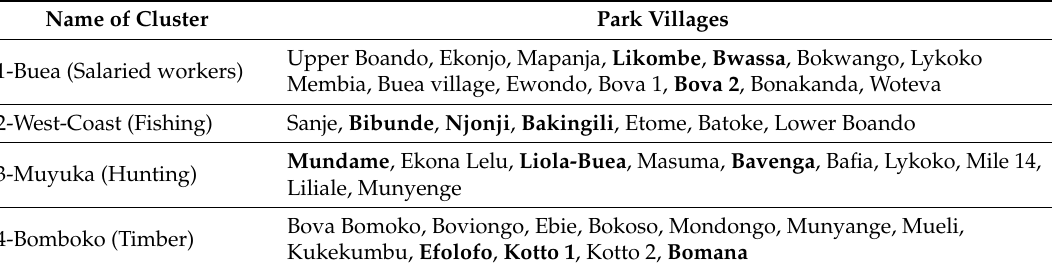
Table 2. The four clusters and corresponding villages co-managing MCNP with sampled villages in